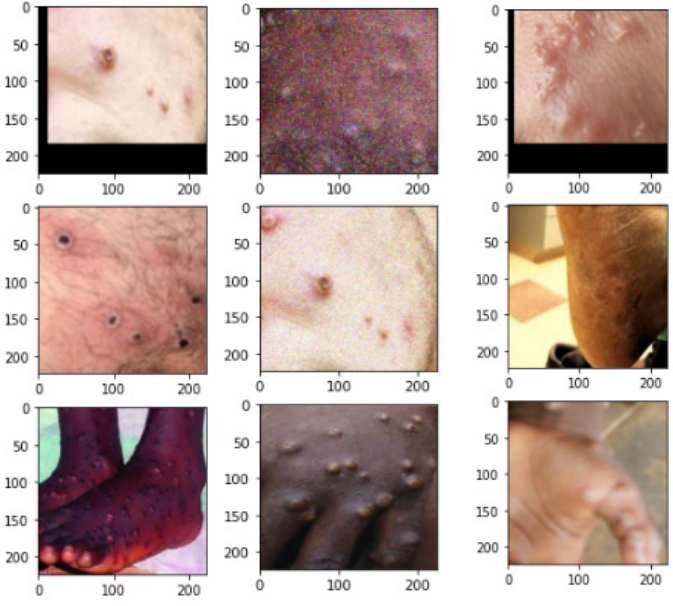
Figure 1. Sample